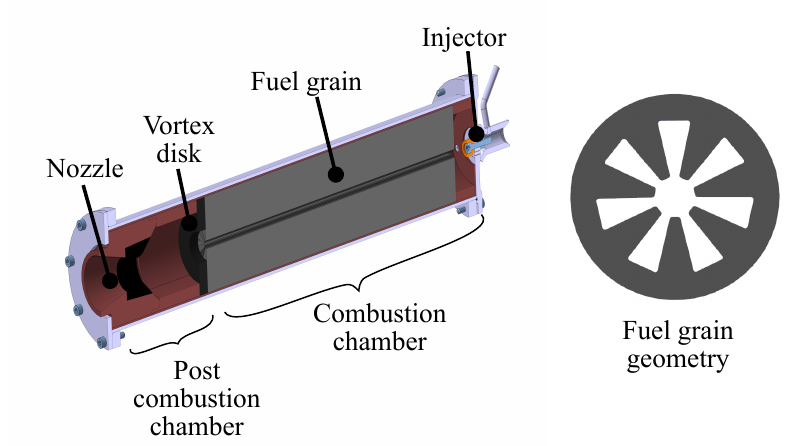
Figure 3. Design of the engine HYDRA